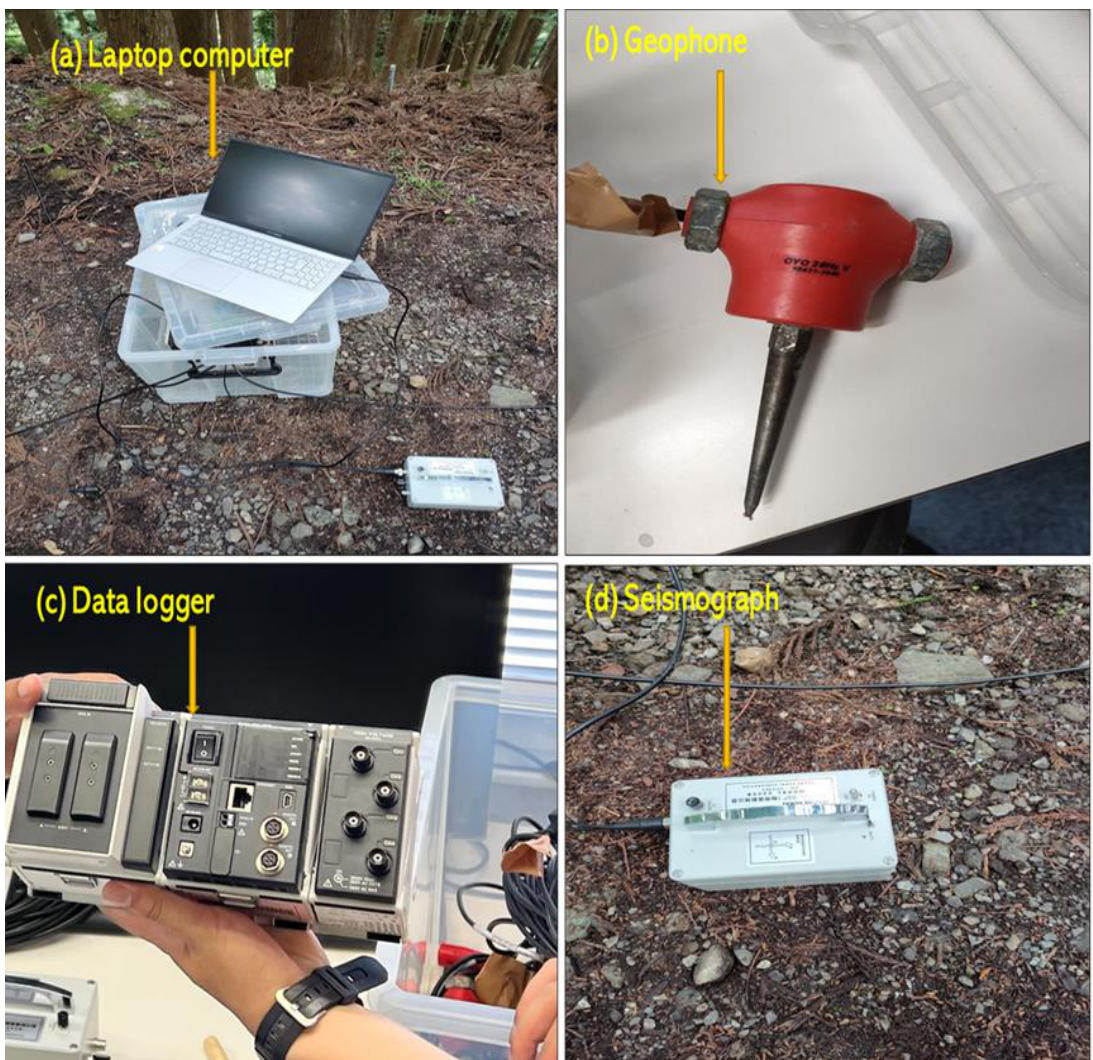
Figure 4. Ground vibration monitoring instruments ( a ) laptop computer, ( b ) geophone, ( c ) data logger, and ( d ) seismograph.